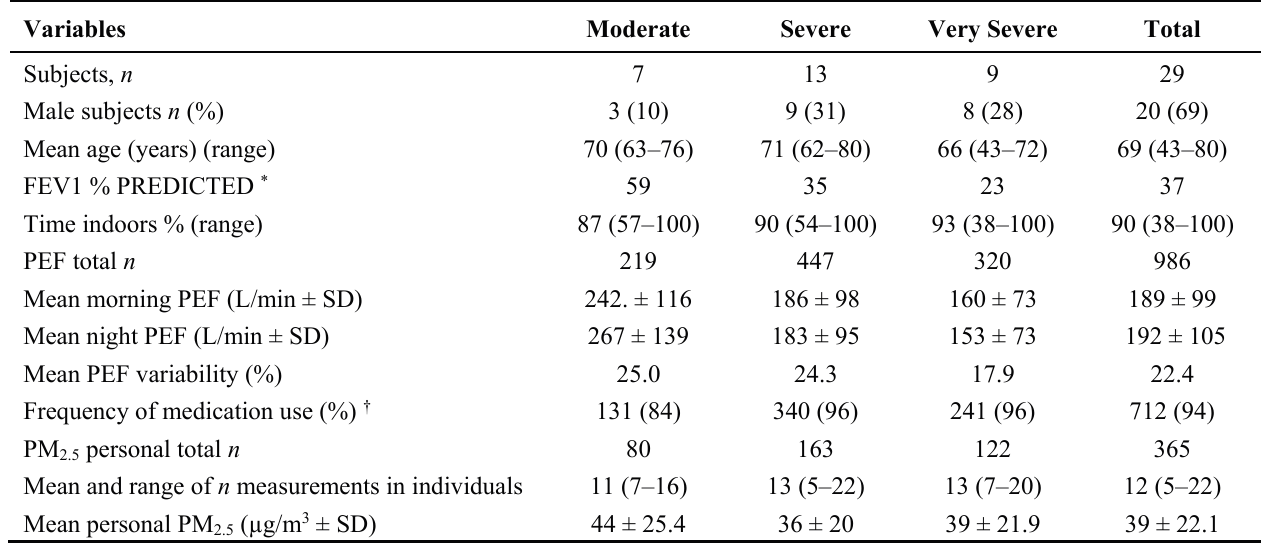
Table 1. Participant characteristics by chronic obstructive pulmonary disease (COPD) severity